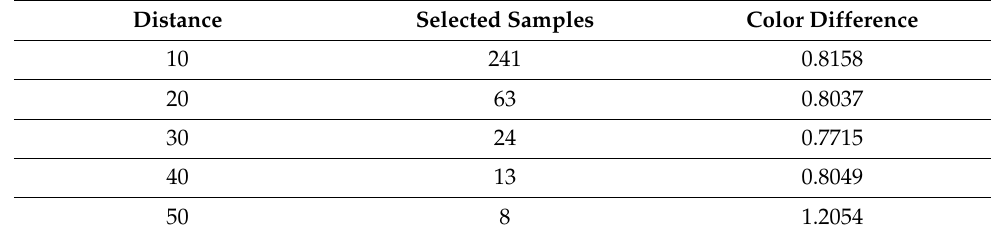
Table 2. The relationship between recovery accuracy and distance.